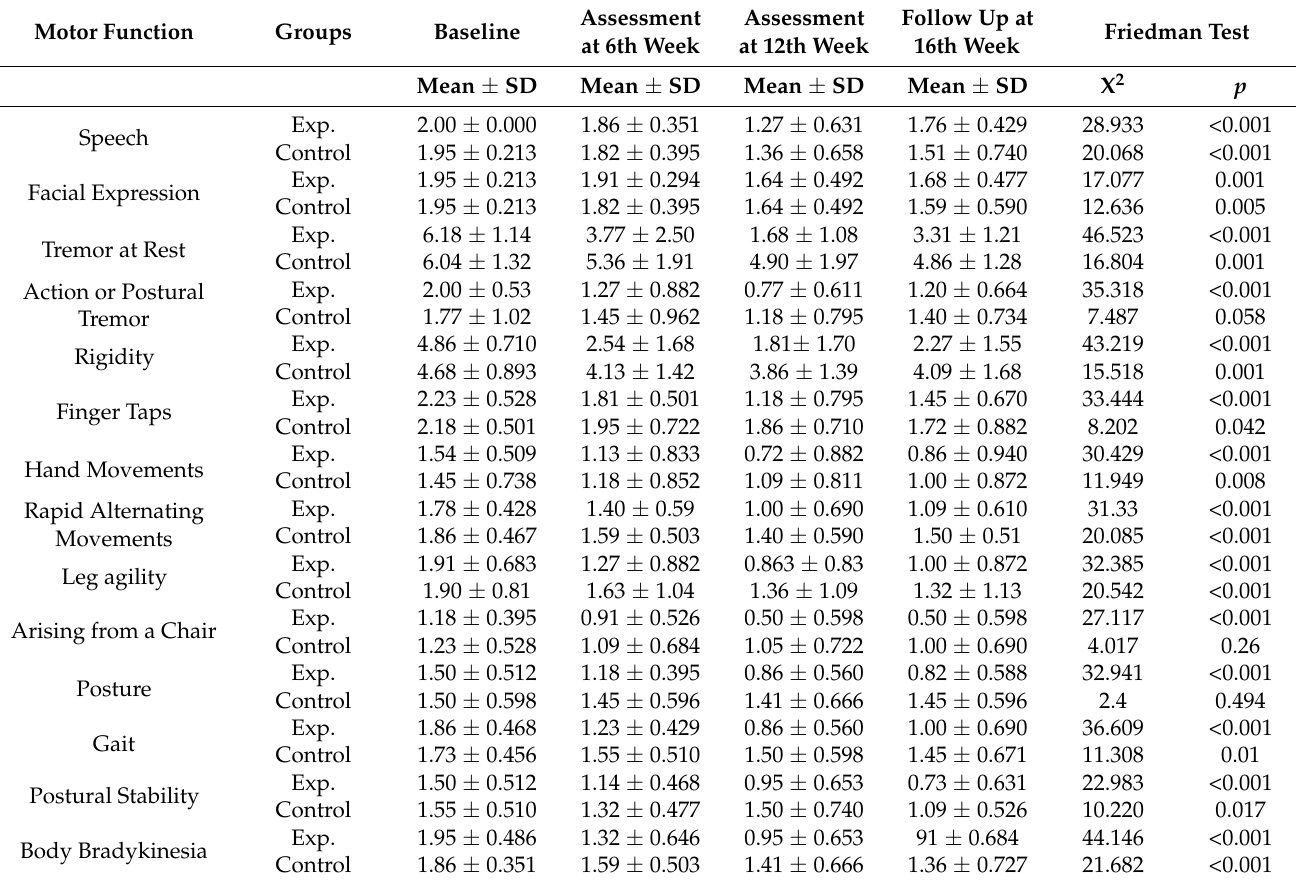
Table 3. Within group comparison of mean scores of